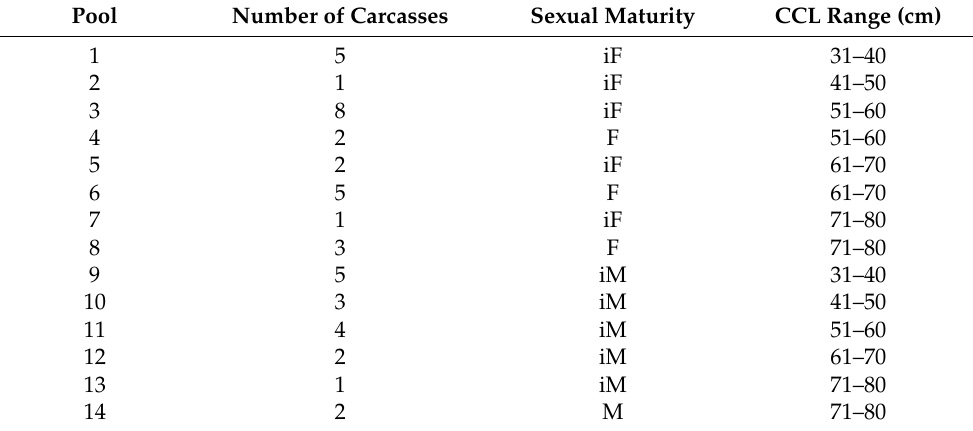
Table 1. Variables considered in pool